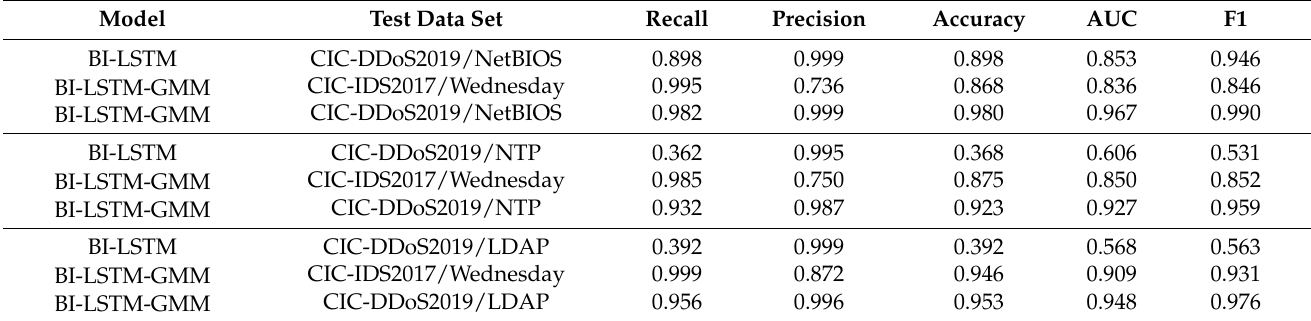
Table 6. Performance of the BI-LSTM and BI-LSTM-GMM with “CIC-IDS2017/Wednesday” as the old traffic and “CIC- DDoS2019” as the new